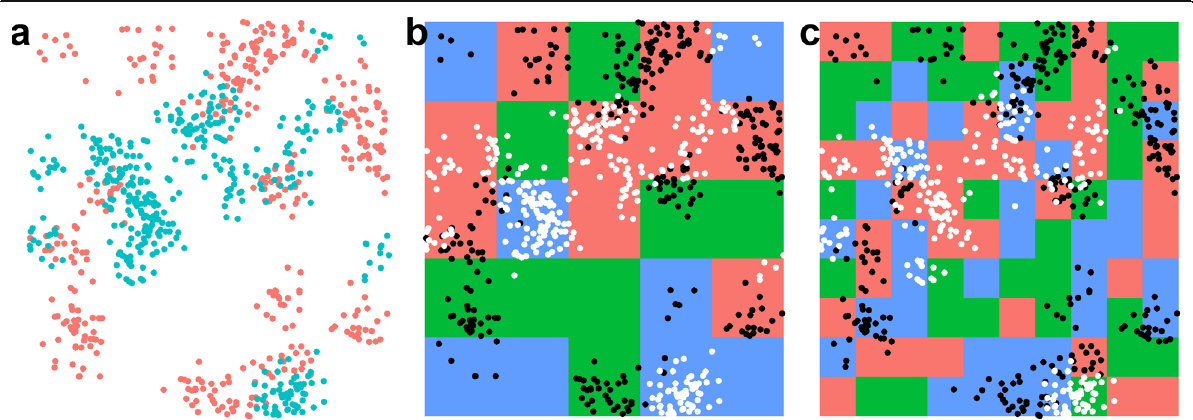
Fig. 5 An example of the same simulated spatial distribution of clustered pathogen and BCA propagules in a homogenous ( a ), and heterogeneous with a large ( b ) or small grain size ( c ). Patches with green colour favouring the BCA, blue colour favouring the pathogen, and orange colour neutral. The same spatial patch pattern was used for all simulation runs. In this example, the ratio of survival ability between the pathogen and the biocontrol (or vice versa) is